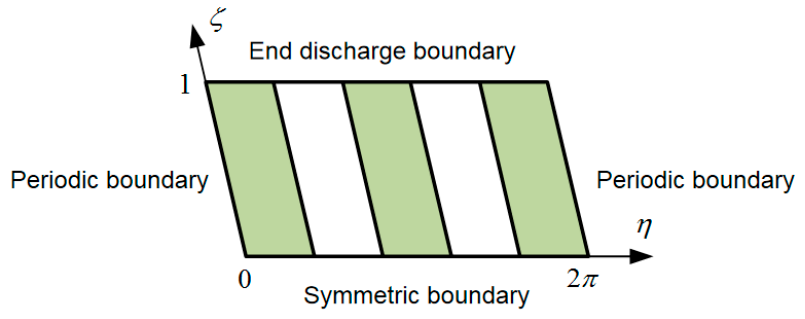
Figure 5. Diagram of the bearing boundary.